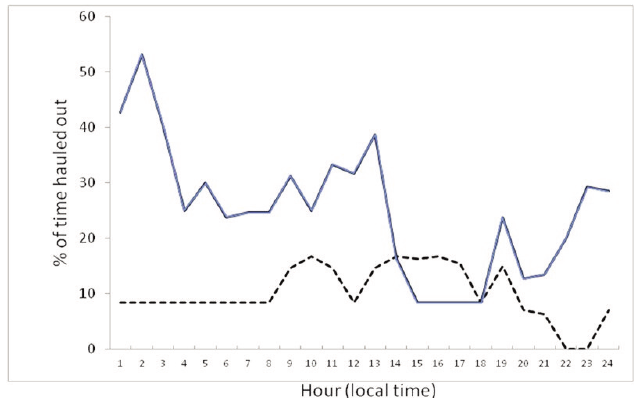
Fig. 6 : Percentage of time (per 24 hour) that an adult male walrus hauled out at the Faroe Islands. The solid line shows fifteen haul-out ses- sions over thirteen days of during 24 February–5 March and 25–29 March 2010. The dashed line shows haulouts after the walrus had left the Faroe Islands (5 haul-outs over 12 days during 30 March and 24 April